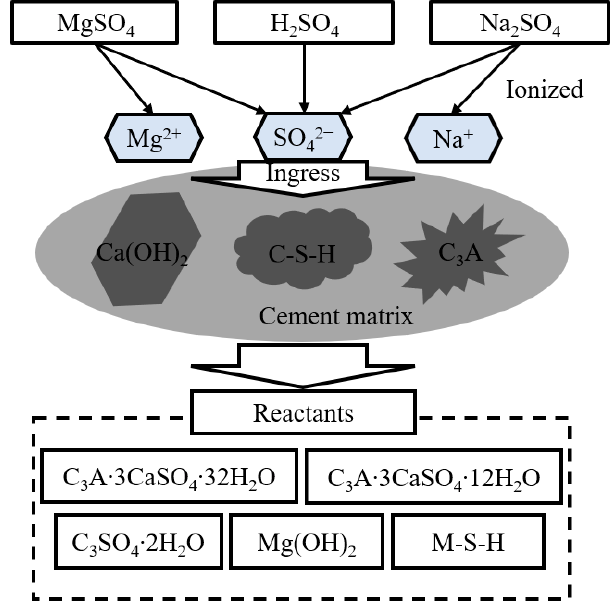
Figure 2. Deterioration mechanism of cement matrix exposed to sulfate ion ingress.